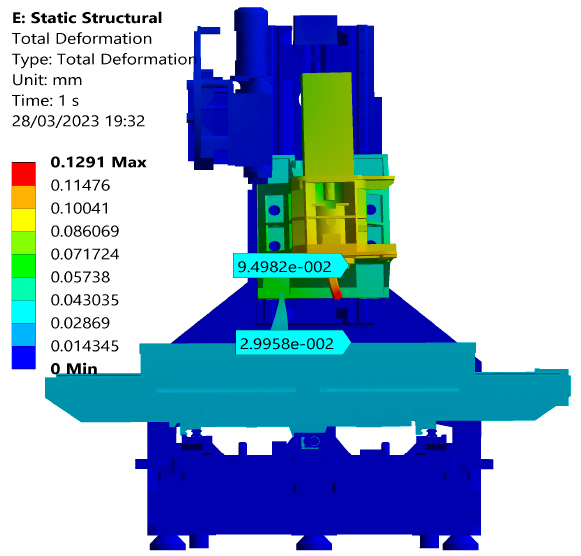
Figure 4. Static analysis results.